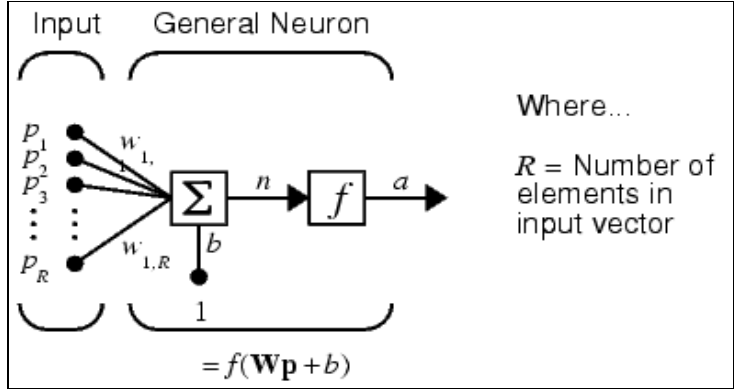
Figure 8. Structure of a simple neural cell with leading nutrition.